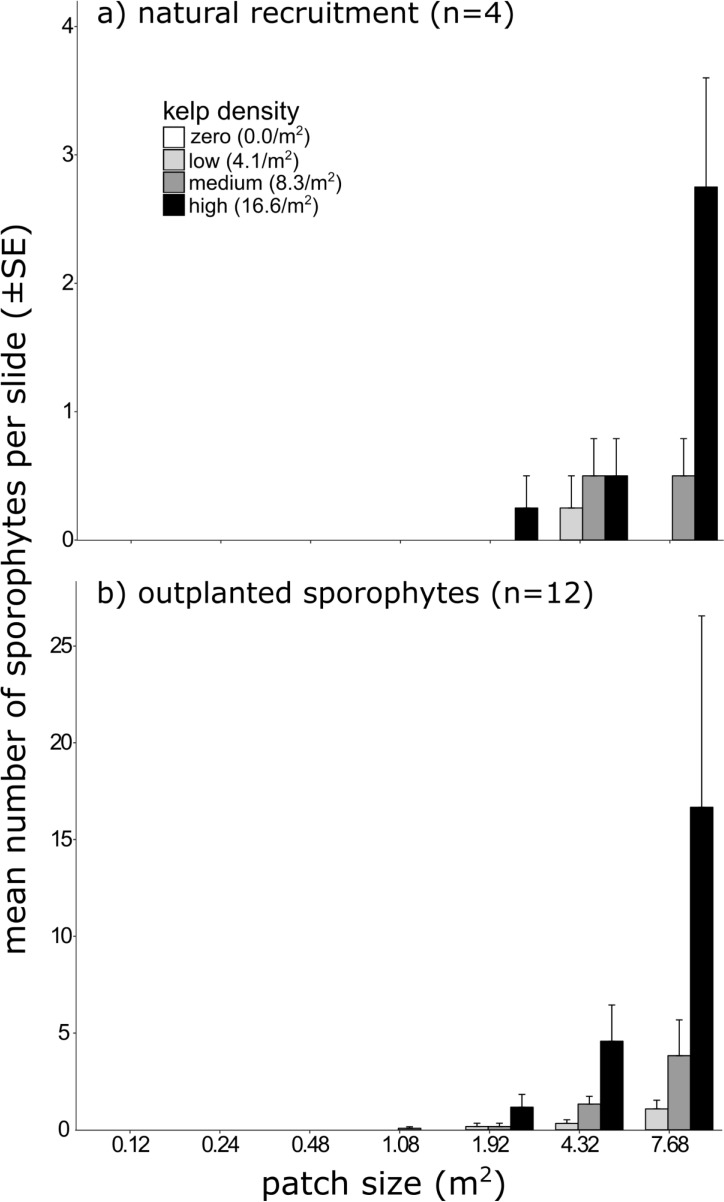
Recruitment and survivorship of microscopic sporophytes on experimental patch reefs.Mean number (± SE) of (a) naturally recruited microscopic Ecklonia radiata sporophytes, dependent on patch size and kelp density; and of (b) surviving microscopic sporophytes grown on slides 42 days after outplanting, dependent on patch size and kelp density. Note the different y-axis scales and, that recruitment at patch size 1.08 m2 (Fig b) was in the medium density treatment.